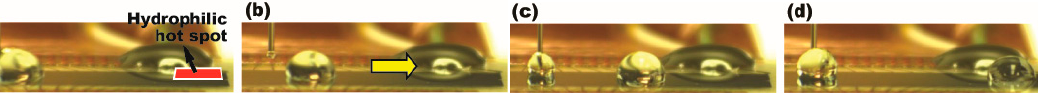
Figure 4. Video snapshots showing a complete set of the droplet manipulations to achieve effective two-phase cooling on SDMF. A 12.5 µL water droplet is injected, directly transported, and immobilized on the hydrophilic hot spot. The droplet expands the contact area and increases the heat transfer rate on the hydrophobic surface. A 35 dc bias was applied. ( a ) Before; and ( b ) after the droplet injection, t = 0 s; ( c ) t = 3.2 s; and ( d ) t = 6.5 s.